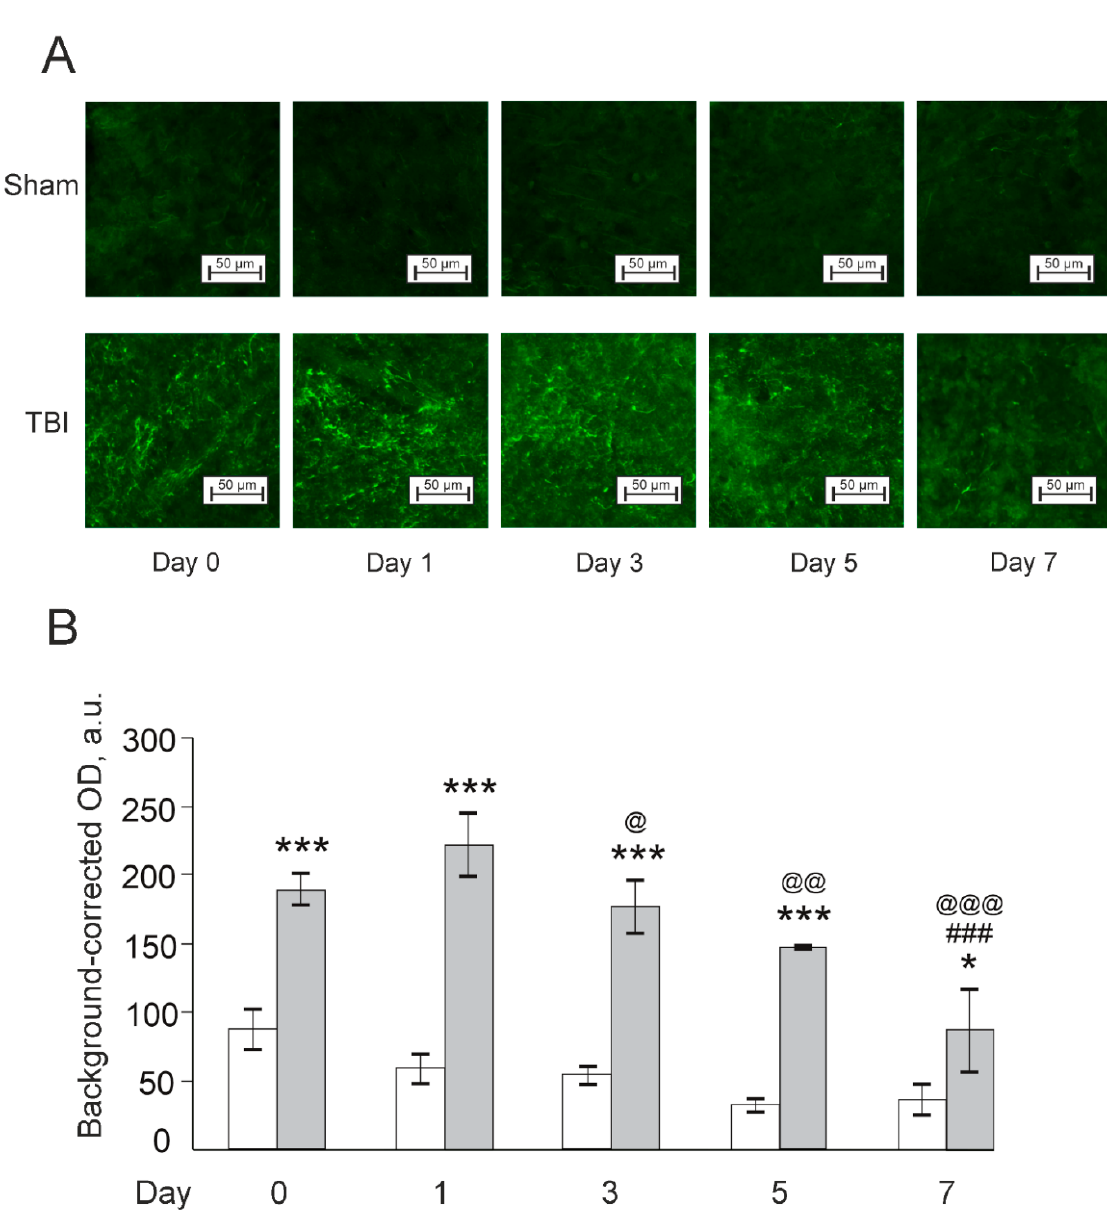
Figure 10. Effects of laser-induced lesion (TBI model) on the expression of microglial marker Iba1 in zebrafish telencephalon on Day 0 (30 min after the lesion), Days 1, 3, 5, and 7 after the injury. ( A ): Representative images of Iba1 immunoreactivity in the telencephalon; magnification, ×200. ( B ): Quantitative results. White bars represent Sham groups, grey bars TBI groups. Data are expressed as mean ± SEM ( n = 3–4 per group). * p < 0.05, *** p < 0.001 vs. Sham group on the same day after the injury; ### p < 0.001 vs. TBI group on Day 0; @ p < 0.05, @@ p < 0.01, @@@ p < 0.001 vs. TBI group on Day 1.